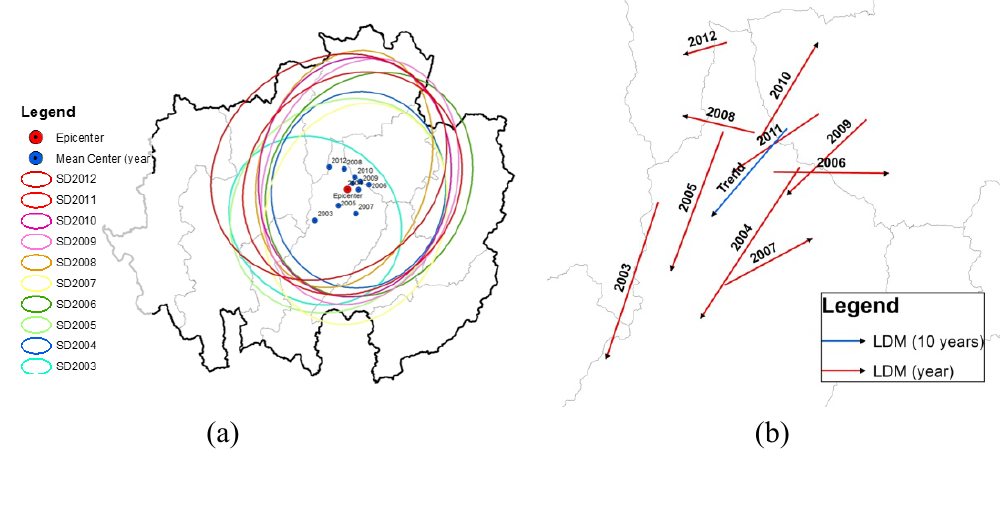
Figure 7. ( a ) HFMD Mean Center and Standard Deviation Ellipse and ( b ) Linear Directional Mean from 2003 to